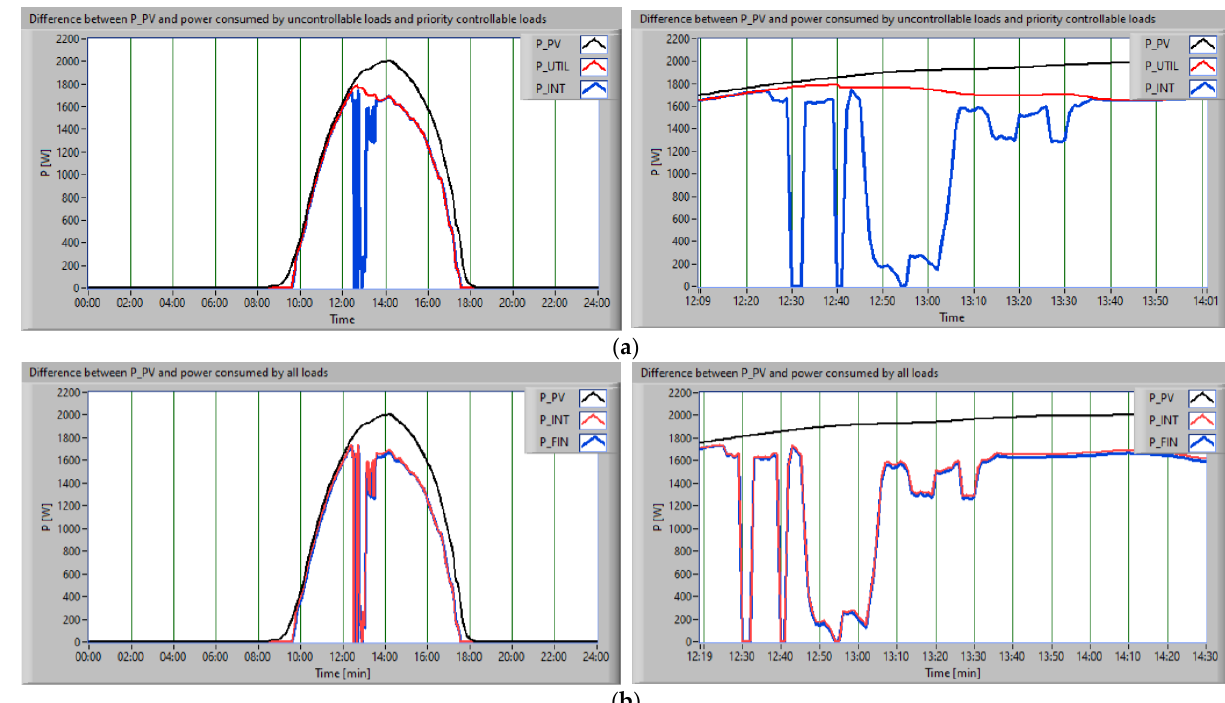
Figure 11. Priority assignments for loads in scheduling approach, scenario 1.